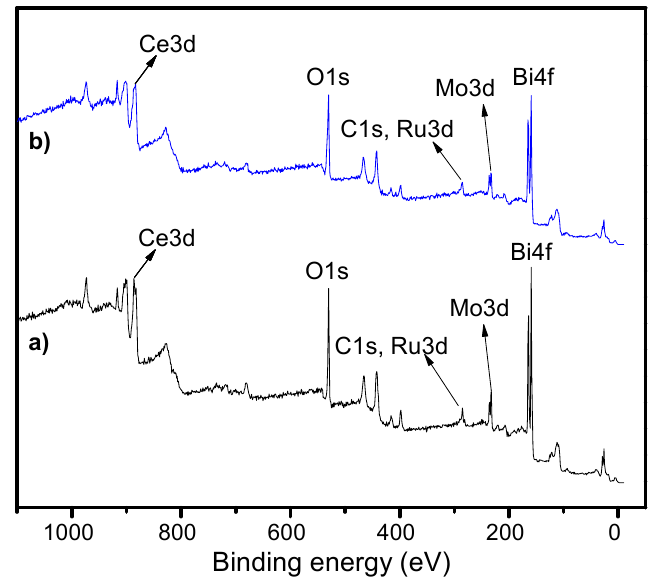
Figure 5. General XPS scans of ( a ) OCMBR1 and ( b ) OCMBR2 catalysts.